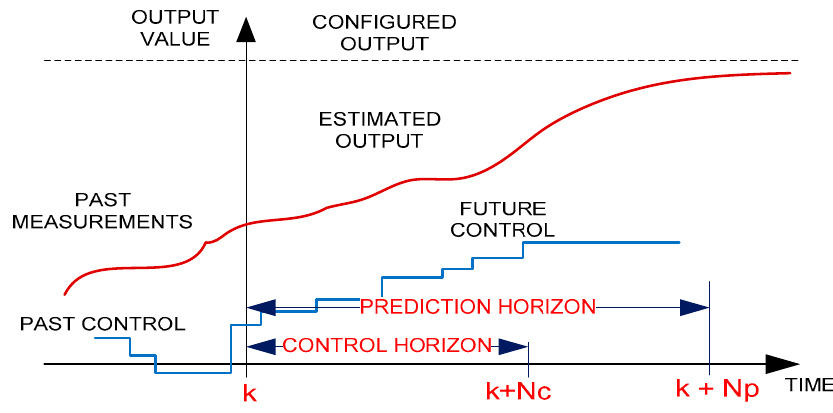
Figure 11. Prediction and Control Horizons.